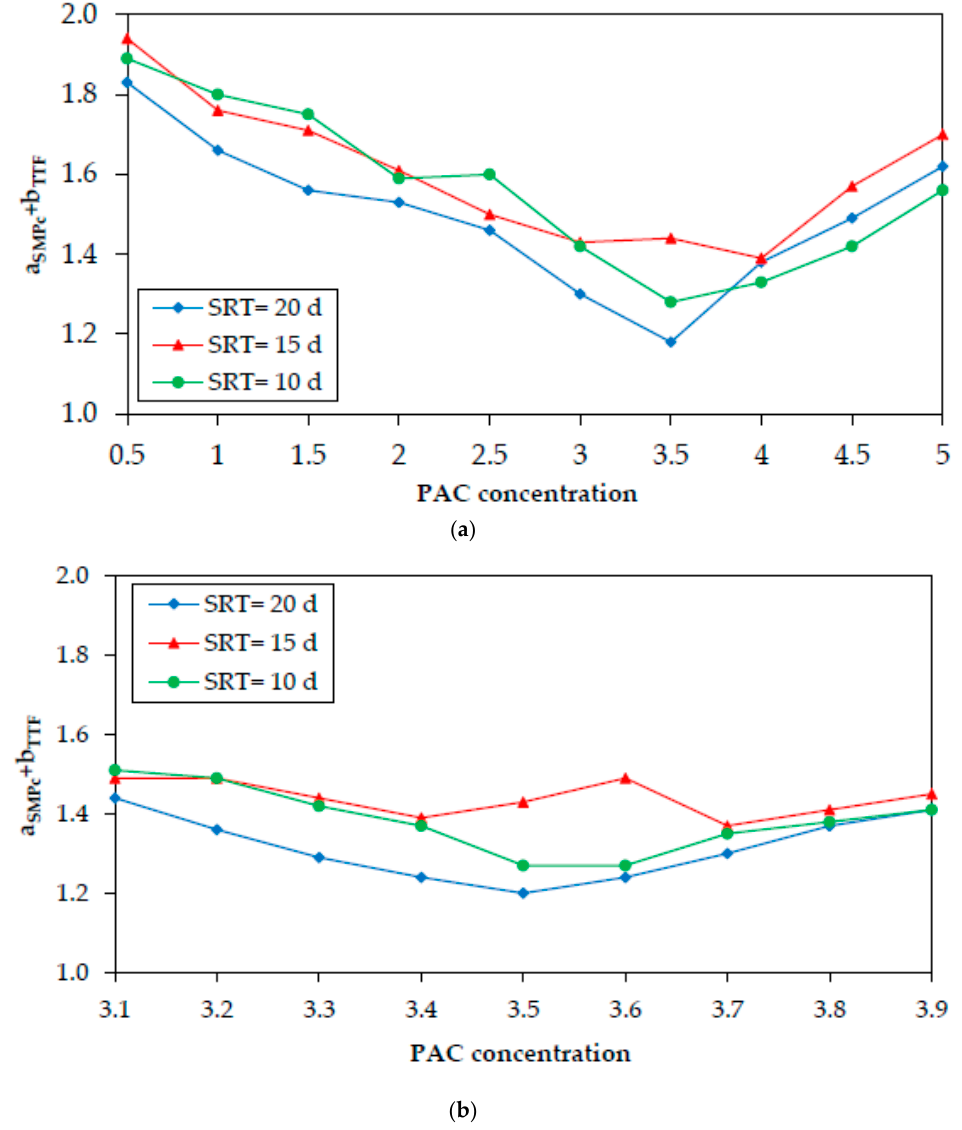
Figure 3. Sum a SMPc + b TTF after the batch-mode addition of powdered activated carbon (PAC) at (a) 1– 5 g/L and (b) 3.1–3.9 g/L, for SRT = 20, 15, or 10